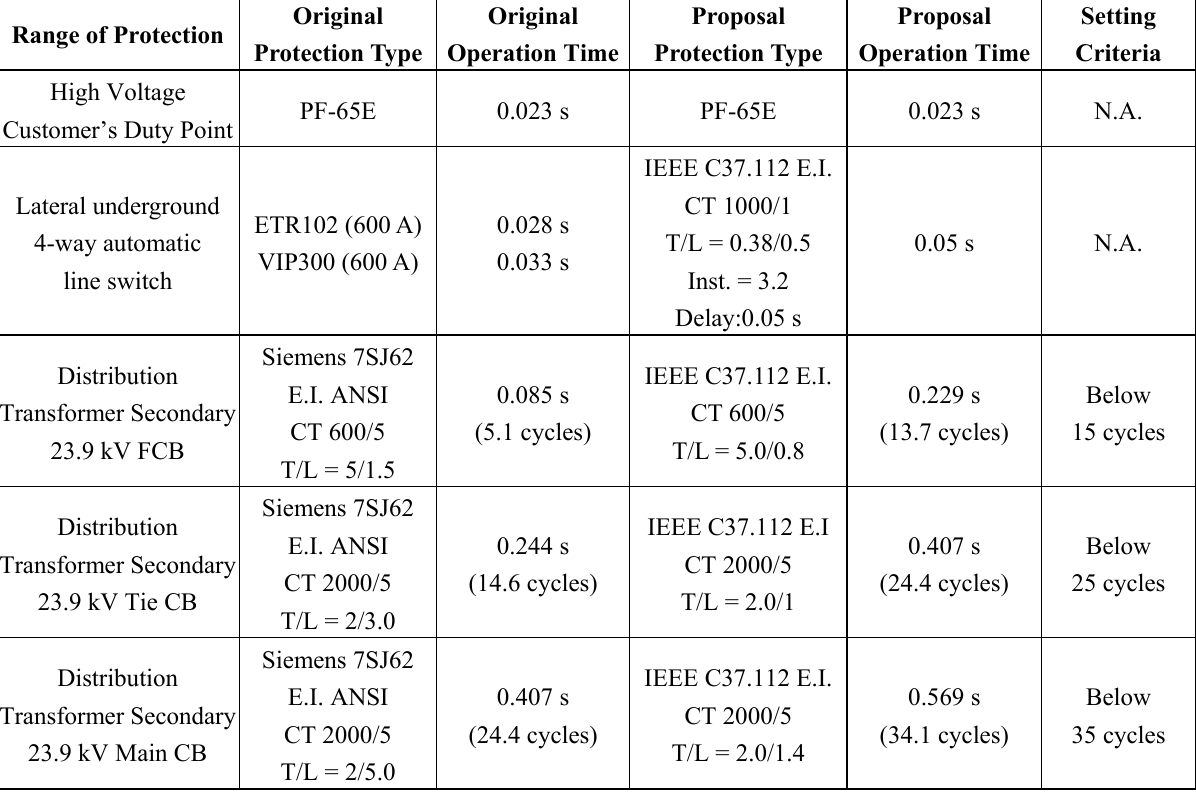
Table 6. Original and proposed CO relays of Fuyuan